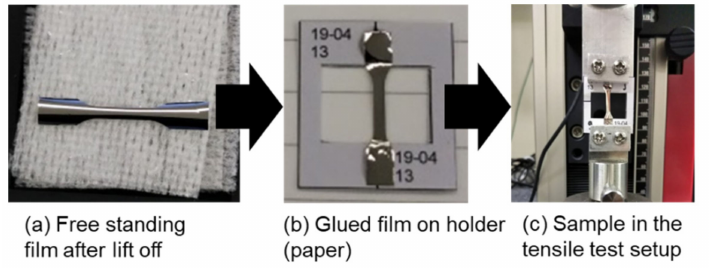
Figure 2. Tensile test sample: ( a ) after the fabrication process, ( b ) glued to a paper frame for handling, and ( c ) clamped into tensile test